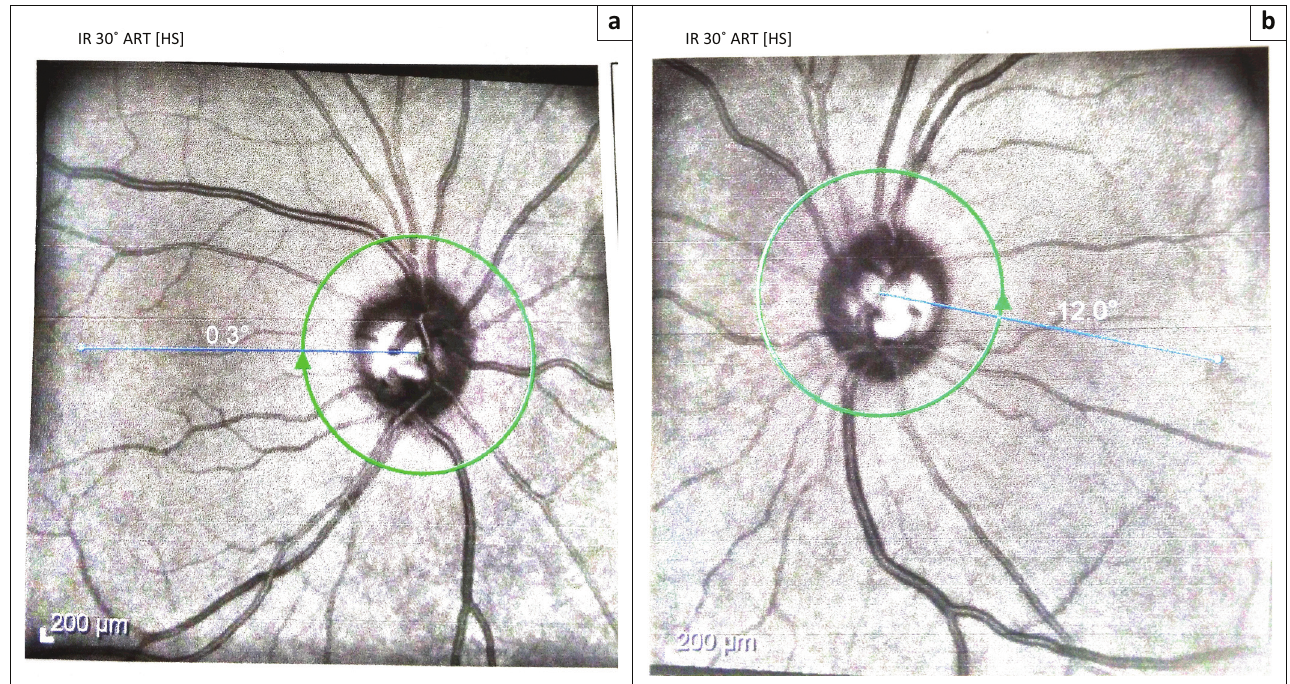
FIGURE 1: Showing the narrowing of the neuroretinal rim of the optic nerve in the (a) right eye and (b) left